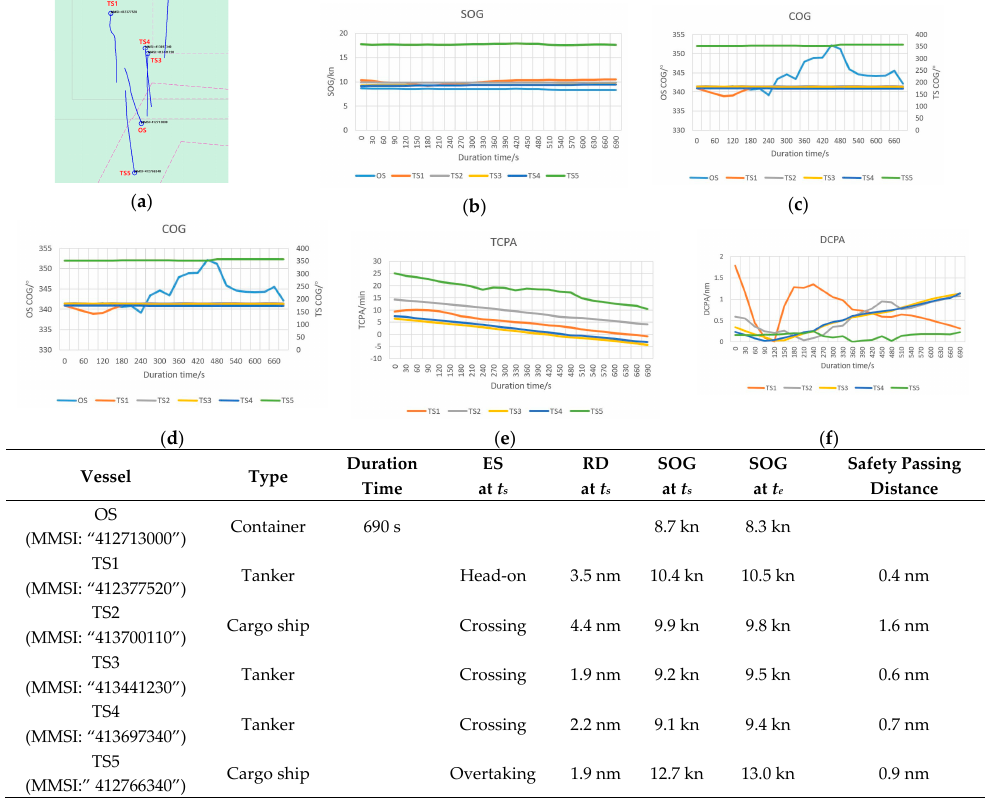
Figure 5. ‘multi-ship’ situation ( a ) trajectory; ( b ) SOG; ( c ) COG; ( d ) RD; ( e ) TCPA; ( f ) DCPA; ( g ) scenario parameters aspects.